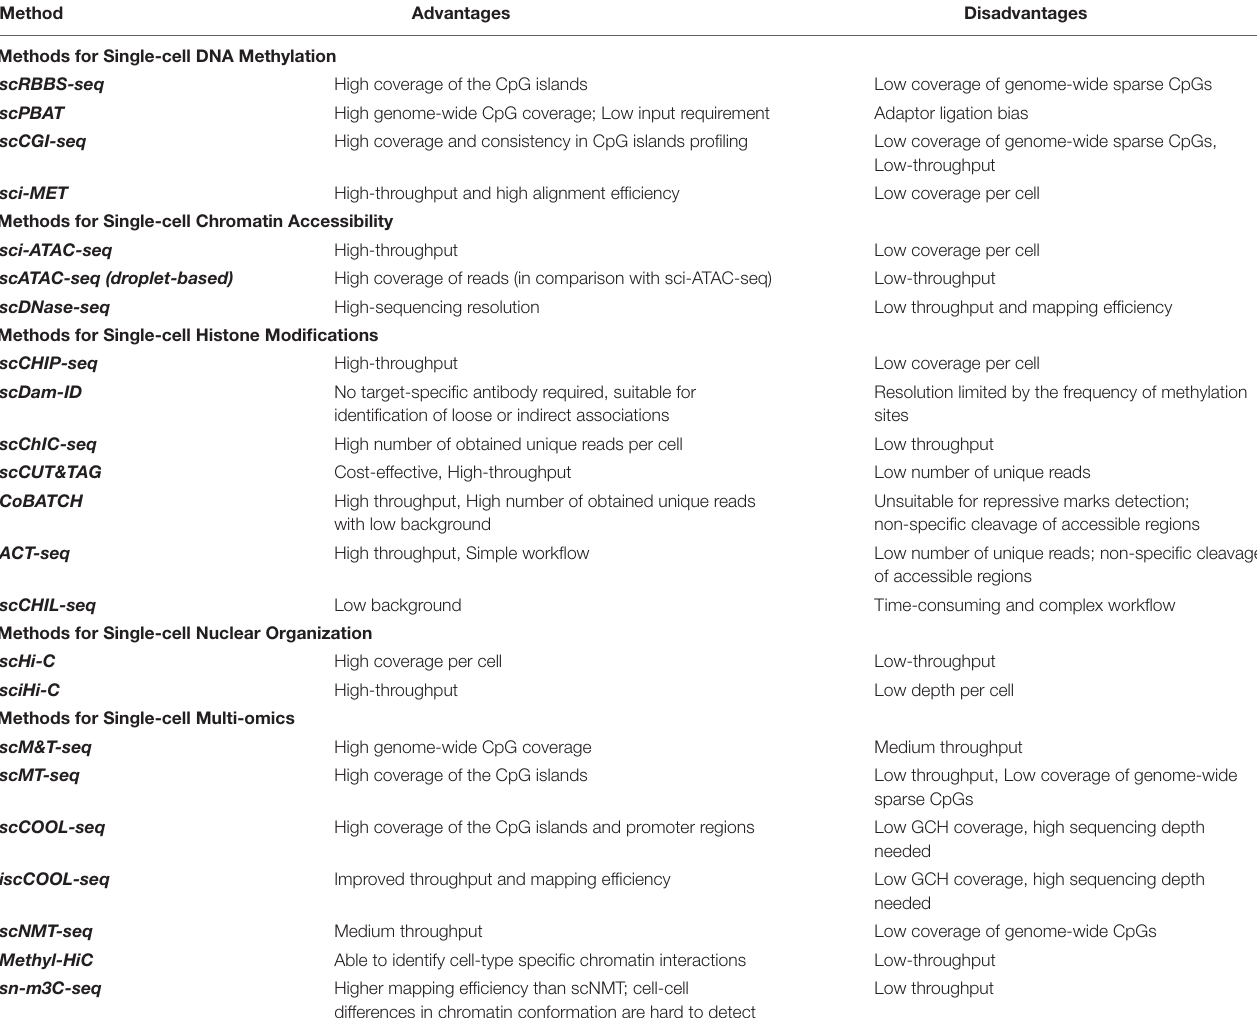
TABLE 2 | Comparison of single-cell epigenomic